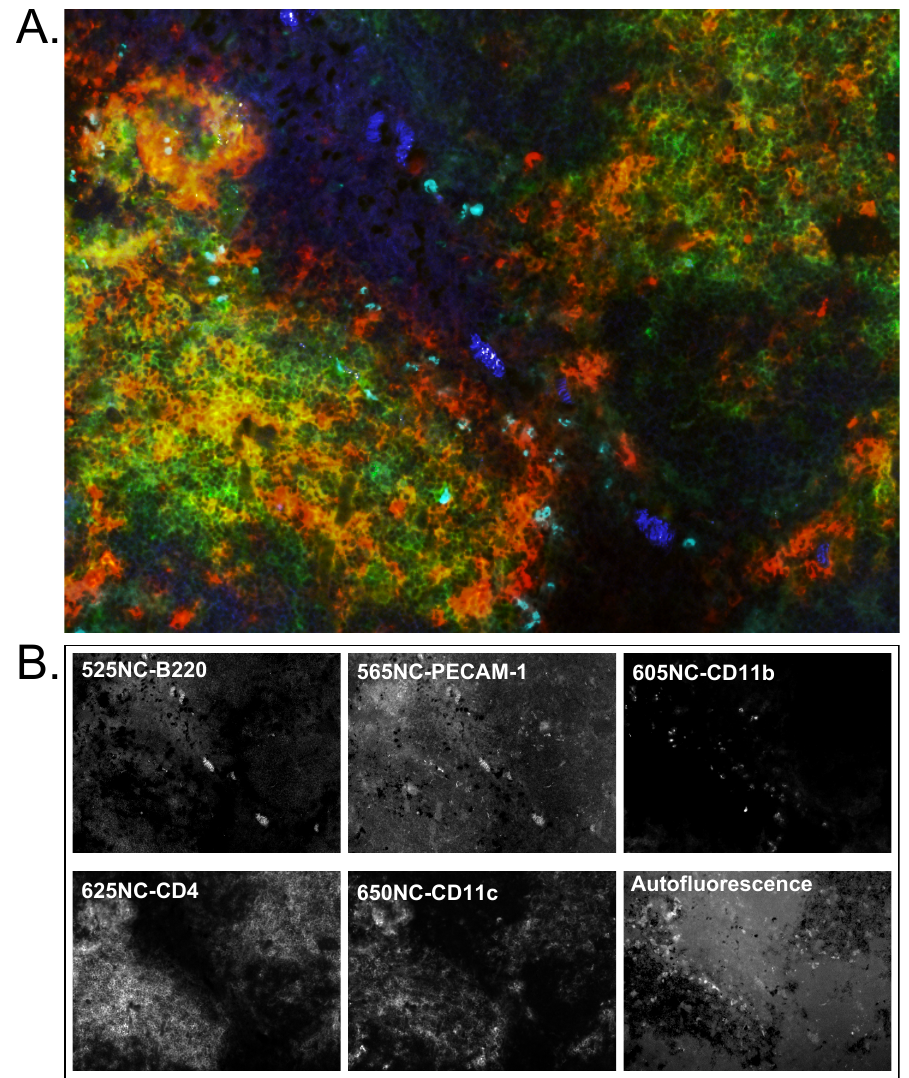
Figure 3. ( A ) Five-color multiplexed image (psuedo-colored composite) of mouse